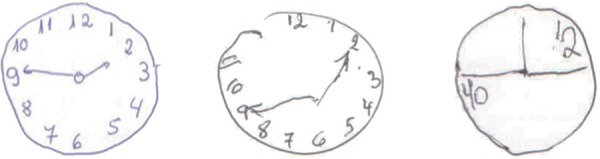
Examples of CDT score in accordance with the specific algorithm method
based on Sunderland et al.10: 9, 5 and 2 (right to left), respectively.